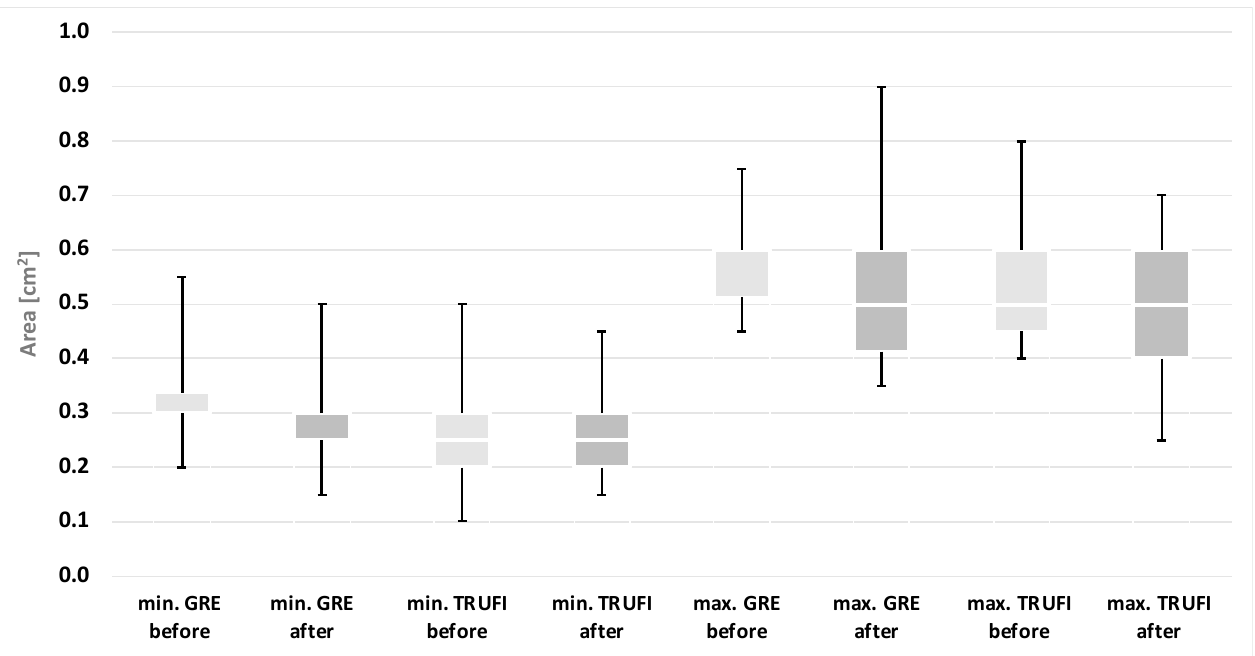
Figure 6. The minimum and maximum values of the area of the rima glottidis compartments ob- tained with the use of dynamic MRI sequences in the group of patients with paralyzed vocal folds after surgery compared to the preoperative examination results. * p < 0.05.